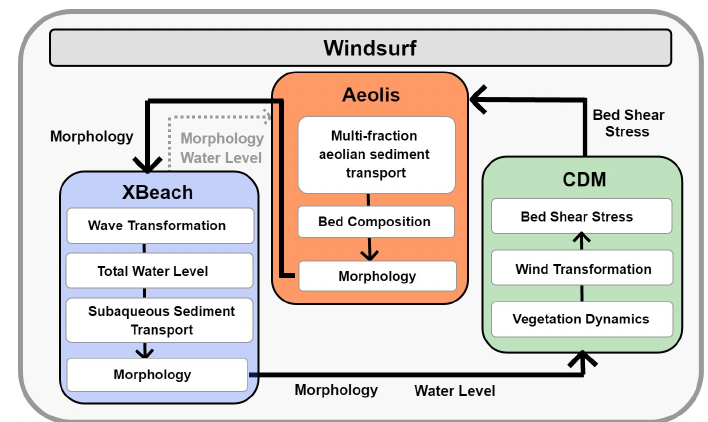
Figure 2. Schematic representing the general Windsurf model framework which includes three standalone numerical models (XBeach, CDM, Aeolis) that are coupled offline through a back-end MATLAB interface. Major processes resolved within each model core and the outputs exchanged by the coupler are shown. Black arrows show the order of model processes and model core boundary condition exchanges. Morphology and total water level information is also exchanged between XBeach and Aeolis, as denoted by the dotted grey